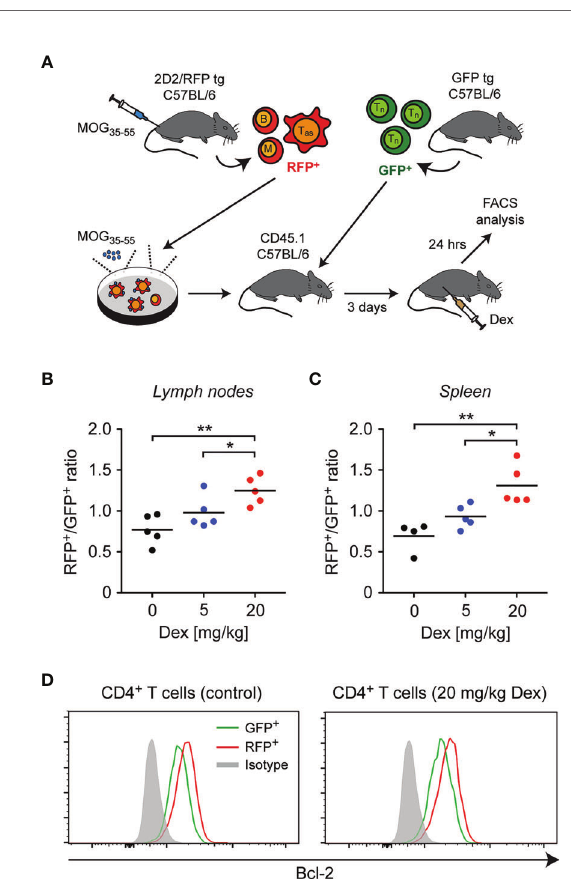
FIGURE 5 | Enrichment of antigen-primed effector T cells after GC treatment in vivo . (A) Setup of the experimental model. (B, C) Weighted ratio of live/ dead – CD45.2 + (antigen-primed) RFP + T cells and (naïve) GFP + T cells from lymph nodes (B) and spleen (C) on day 4 after transfer and 24 hrs after application of the indicated doses of Dex (5 mg/kg or 20 mg/kg) in vivo . Control mice (0 mg/kg Dex) received PBS. Data are depicted as the mean +/- SEM. N=4-5 (biological replicates from individual mice). Statistical analysis was performed by One-way ANOVA followed by a Newman-Keuls Multiple Comparison test. Levels of signi fi cance (depicted for the comparison between control and Dex-treated cultures): *p < 0.05; **p < 0.01. (D) Intracellular stainings of Bcl-2 in (naïve) GFP + and (antigen-primed) RFP + CD4 + T cells isolated from mice treated with 20 mg/kg Dex or left untreated as outlined in panel (A) . Staining with an mIgG2b antibody served as an isotype control. One representative analysis for each condition is depicted as overlayed histograms. T as , antigen-speci fi c T cells; T n , naïve T cells; B, B cells; M, myeloid cells.